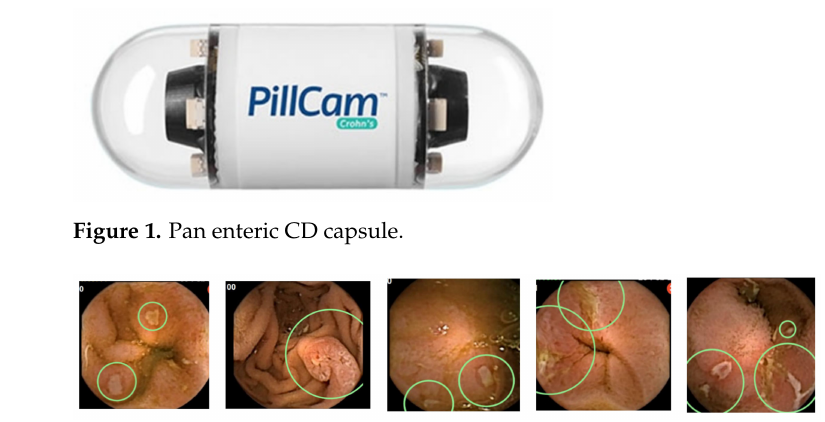
Figure 2. CE images of typical CD-related small-bowel ulcerations. Lesions are circled.